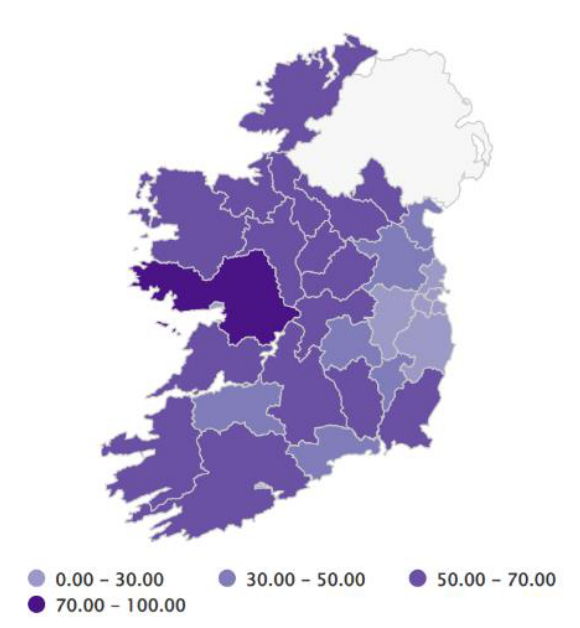
Figure 1: Percentage of homes constructed since 2011 that are one-off houses, 2016 (Central Statistics Office,